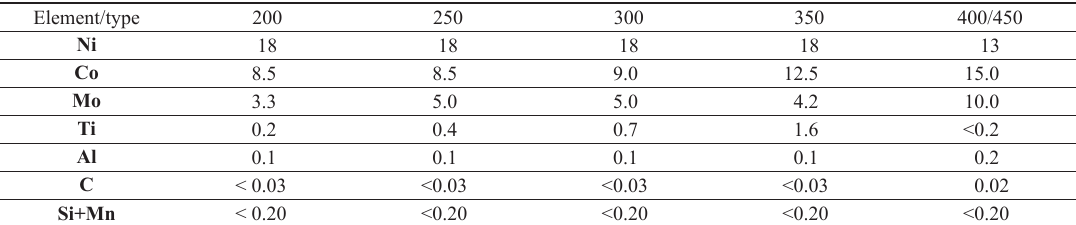
Table 1. Typical nominal chemical compositions of maraging steels (wt.%) 21-23 . Element/type